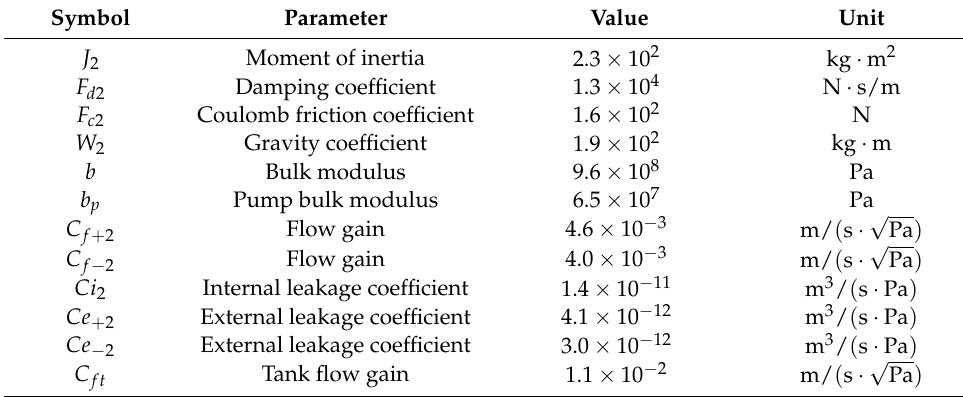
Table 2. Identification result for the nominal numerical